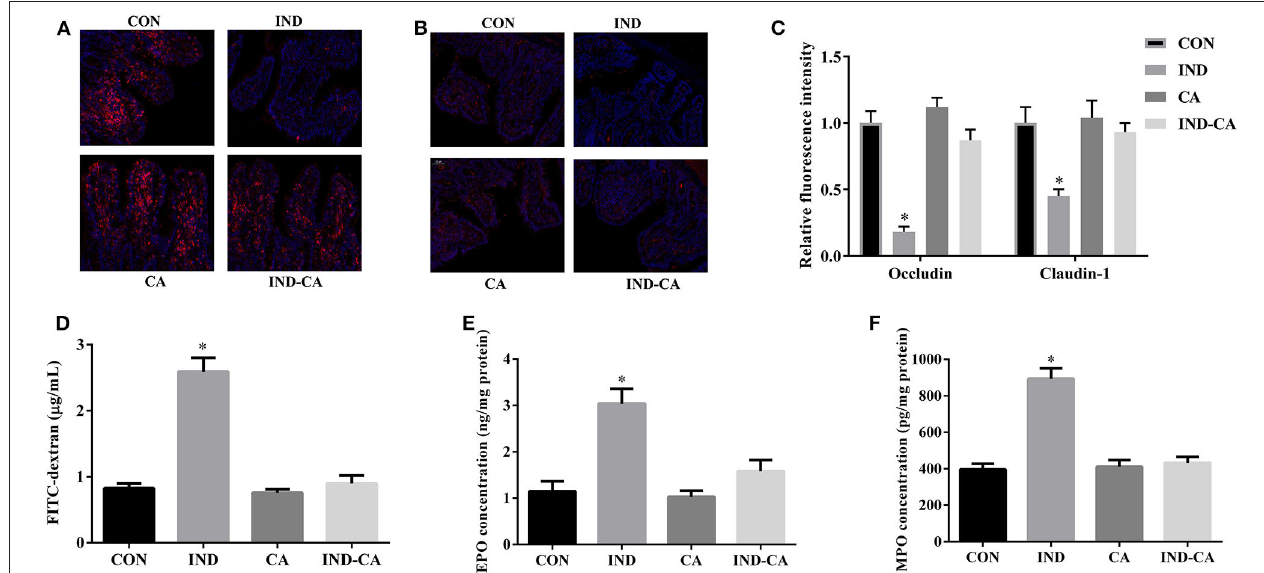
FIGURE 3 | Chlorogenic acid prevented intestinal barrier dysfunction in indomethacin-treated mice. Occludin (A) and claudin-1 (B) expression in colon by immunofluorescence assay (Red, tight junction proteins; Blue, DAPI); (C) Relative fluorescence intensity of occluding and claudin-1 ( n = 3); (D) Concentration of FITC-dextran in serum; EPO (E) and MPO (F) concentrations in colonic tissue. Values are expressed as mean ± SEM, n = 8. * P <